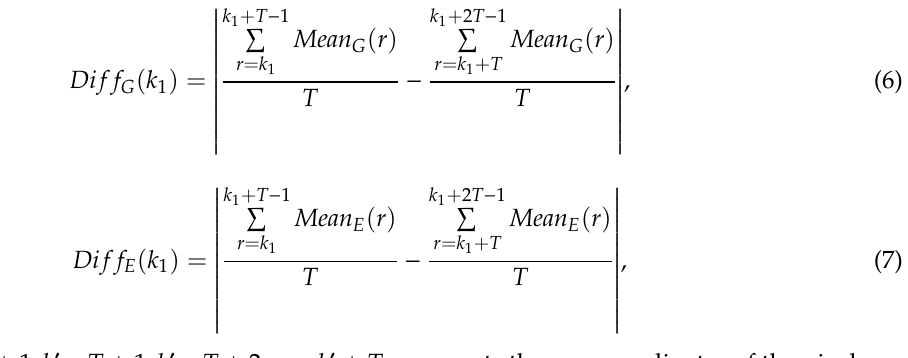
Figure 8. Gray mean difference of coarse positioning in unfavorable conditions: ( a ) out range; ( b ) poor visibility.